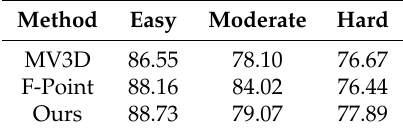
Table 2. Bird’s eye view detection performance: Average precision (AP) (in %) for BEV